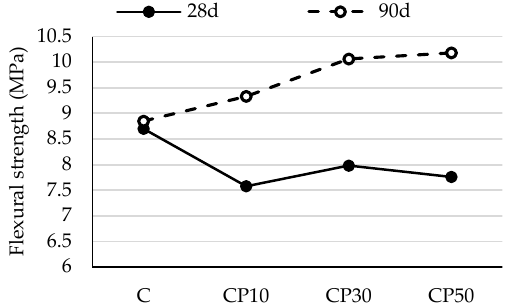
Figure 4. Flexural strength of mortars blended with ceramic powder.